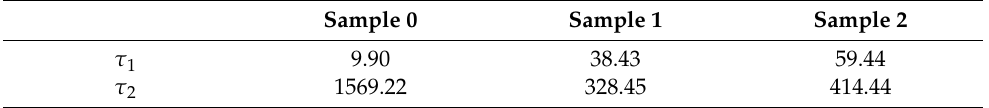
Table 1. Fitted decay constants of